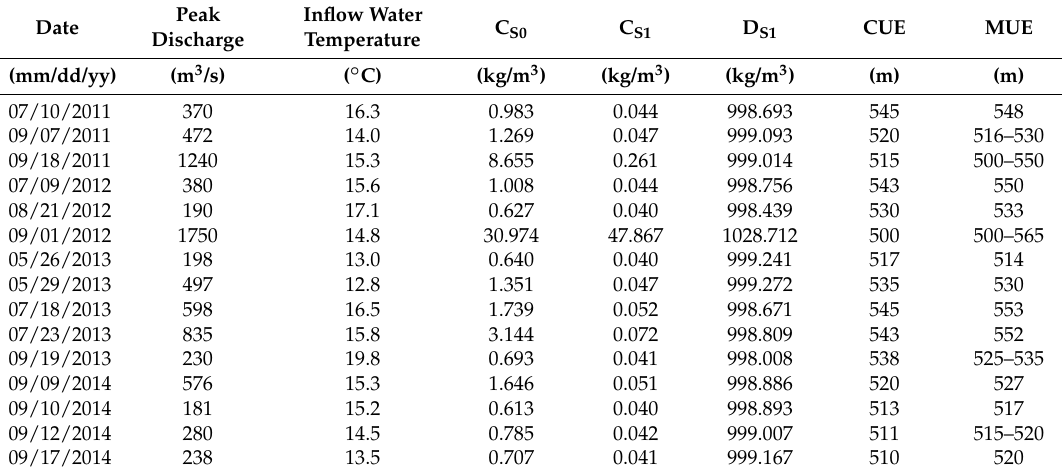
Table 3. Calculated and measured undercurrent